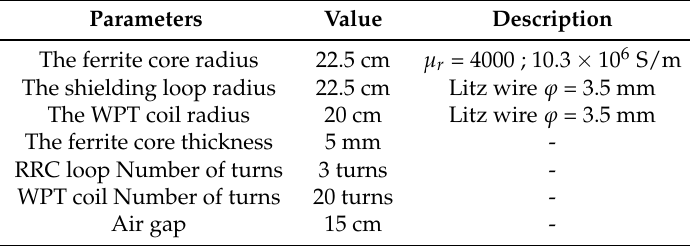
Table 5. The design parameters of the Resonant Reactive Current (RRC) shielding loop position.